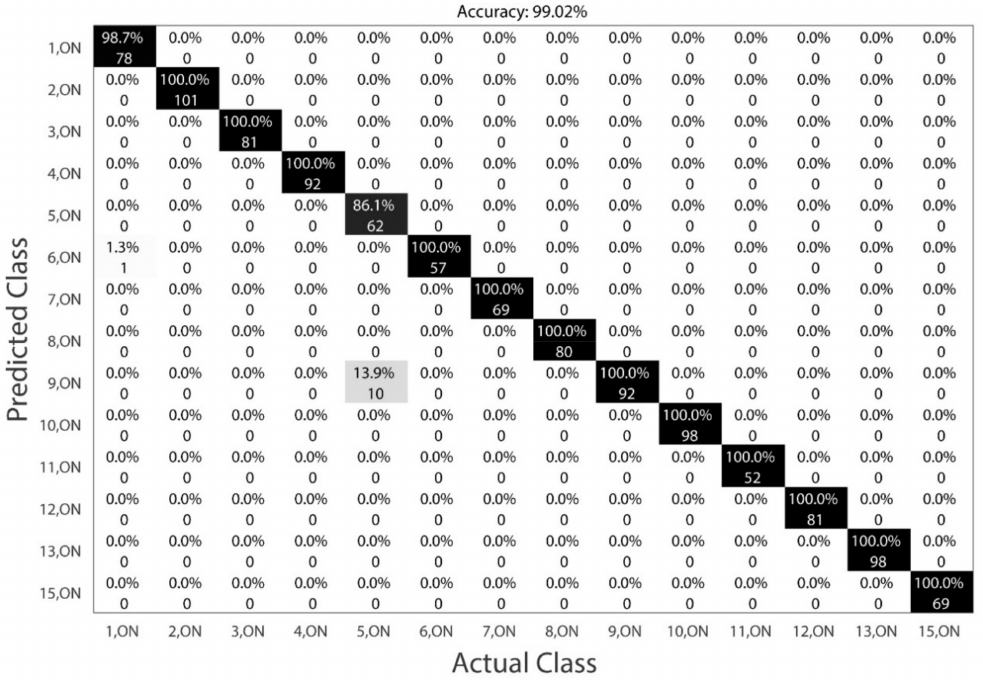
Figure 13. Confusion matrix for the recognition of switching-off events of the tested appliances using the proposed method. Only events detected by the detection algorithm were the subject of